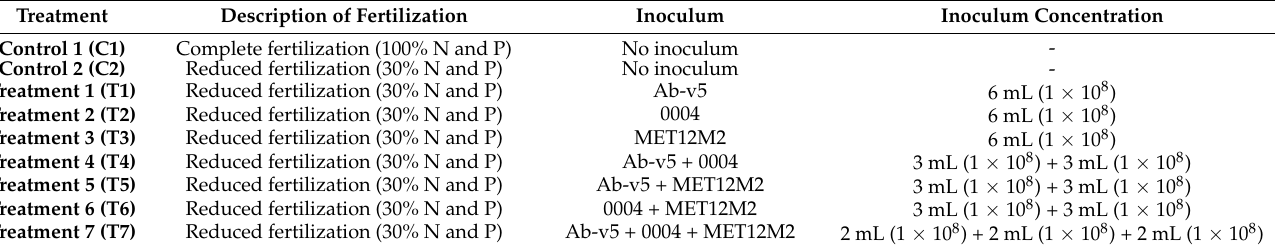
Table 1. Experimental treatments